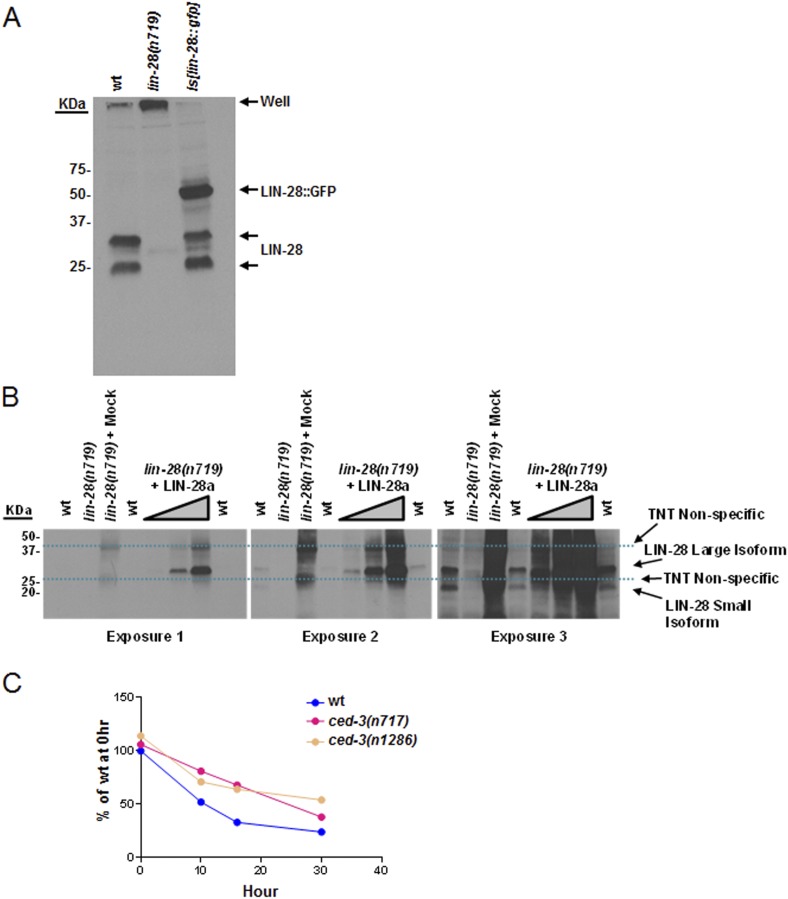
Validation of our newly generated LIN-28 antibody and quantitation of Western blot data.(A) Western blot to demonstrate the specificity of our peptide-purified rabbit-anti-C. elegans LIN-28 antibody. The peptide we chose to immunize the rabbits with is found near the C-terminus (reported in ‘Materials and methods’) and therefore should recognize both the a and b isoforms equally well. Equivalent amounts of extracts from mixed staged wt, lin-28(n719,lf), and a strain with an integrated transgene of lin-28::GFP were resolved by SDS-PAGE then probed with our purified LIN-28 antibody. The Is[lin-28::gfp] strain shows both the endogenous forms of LIN-28 and the shifted fusion protein. (B) The large isoform of LIN-28 (corresponding to the a isoform) was synthesized in vitro then added at increasing amounts into the lin-28(n719,lf) strain to simulate a complex mixture for all other background proteins. Three exposures of the same gel are shown. Two predominant background bands from the in vitro lysate are indicated by dashed blue lines. LIN-28-specific bands (identified in panel A) are indicated. The lin-28(n719) + mock lane has as much in vitro lysate as the most +LIN-28a lane but with a mock vector to show lysate background. This background is not present in the worm extracts (compare the lin-28(n719) lane vs lin-28(n719) + mock). (C) Quantitation of Western blot data from Figure 8A. Arbitrarily, 100% was defined as the intensity of total LIN-28 at 0 hr normalized to actin for the wt strain. Both ced-3(lf) strains were set relative to the wt 0 hr. The subsequent time points for all strains were compared to this 0 hr value.